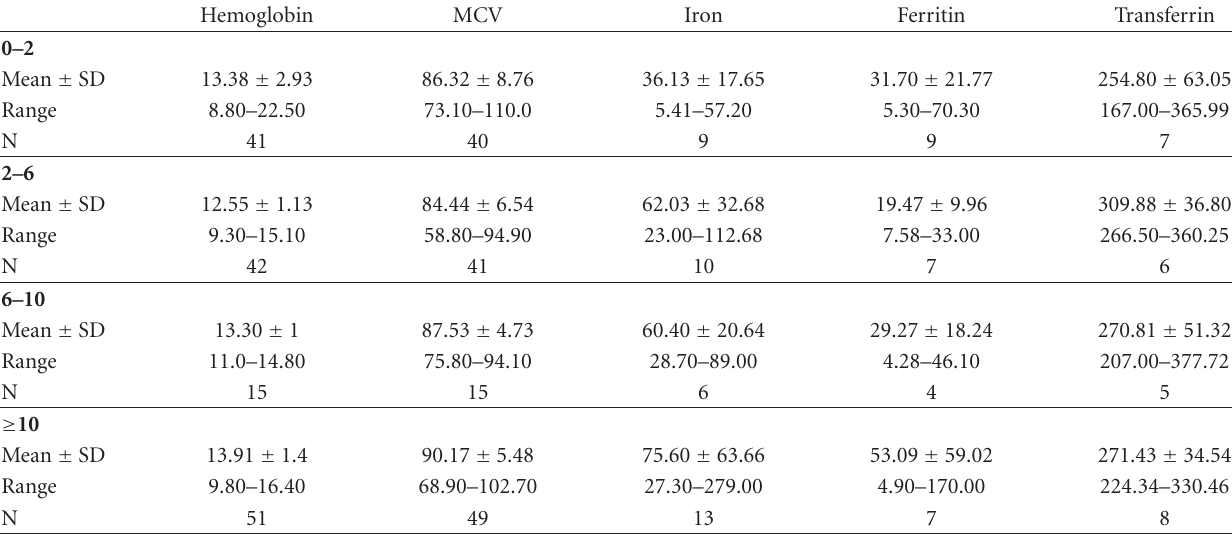
Table 2: Blood counts and iron studies (by age group).